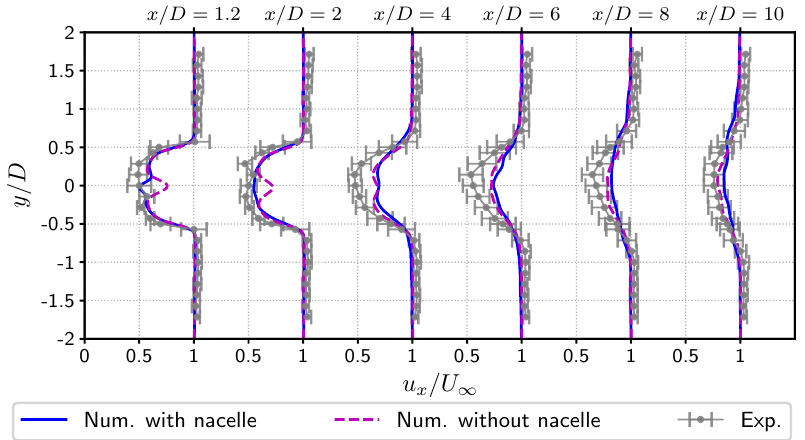
Figure 5. Comparison of the experimental velocity profiles with the numerical results obtained with and without nacelle, for I ∞ = 1.5%, TSR = 3.67, λ = 4.5 m, σ ( λ ) = 0% and R f =